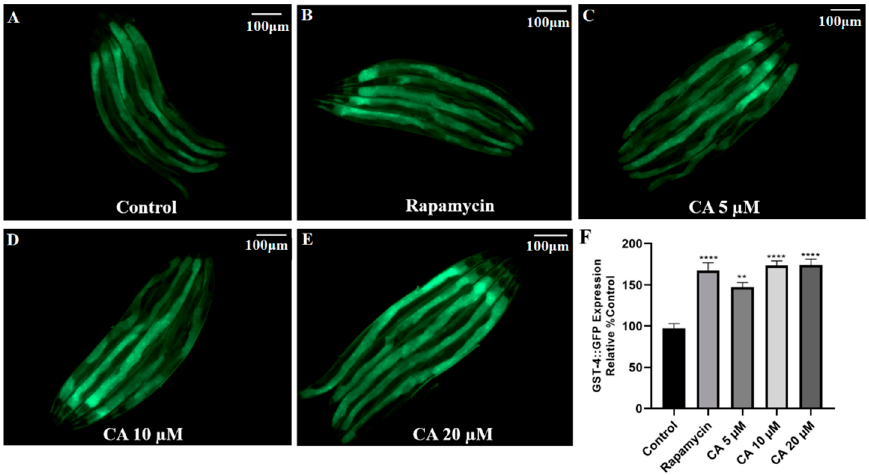
Figure 6. Effect of CA on GST-4 expression in C. elegans . Transgenic worms harboring GST - 4::GFP were treated with DMSO (control) or with rapamycin (1 nM) or CA (5, 10, 20 µ M) for 3 days, followed by imaging with fluorescence microscopy. ( A – E ) Representative images of GST - 4::GFP expression. ( F ) Quantification of GST-4::GFP fluorescence intensity in worms with different treatments as indicated (n = 25 worms per group). The difference was examined with one-way ANOVA with Dunnett’s multiple comparisons test, **** p ≤ 0.0001, ** p ≤ 0.01 vs. control, scale bar = 100 μ m.